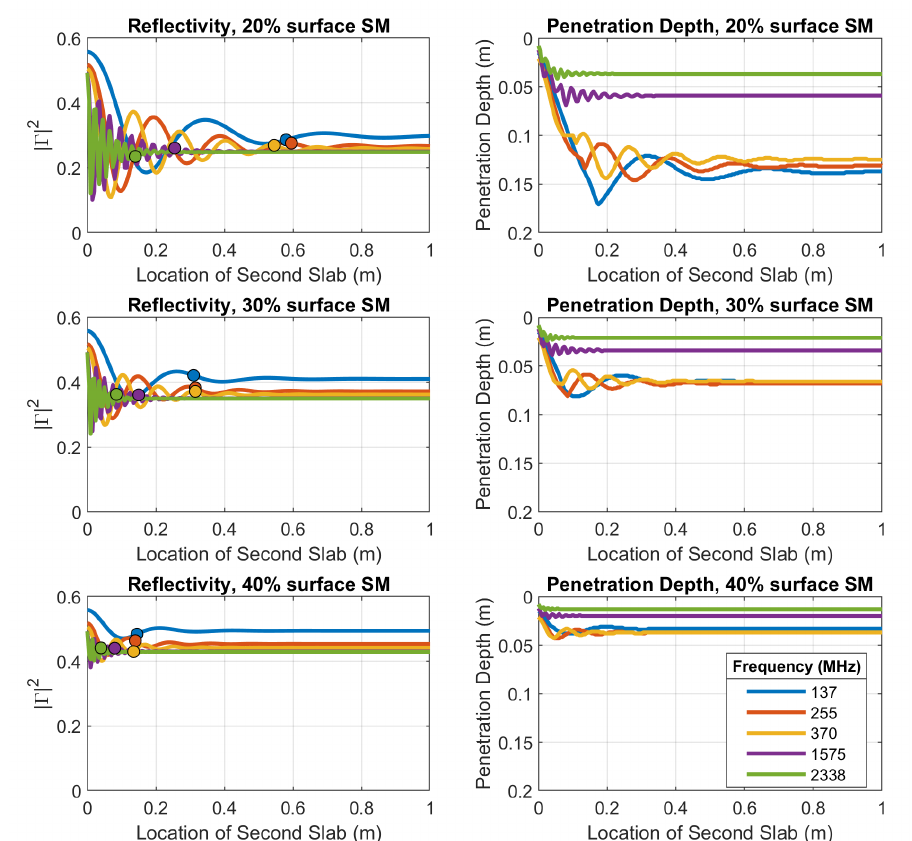
Figure 5. (Left column) Changes in reflectivity due to moving a secondary slab beneath a single dielectric slab and (right column) the corresponding penetration depth for each dual-slab configuration. Each row assumes that the first slab’s SM value is 20%, 30%, and 40% SM, respectively, and all simulations assume a second slab SM of 50%